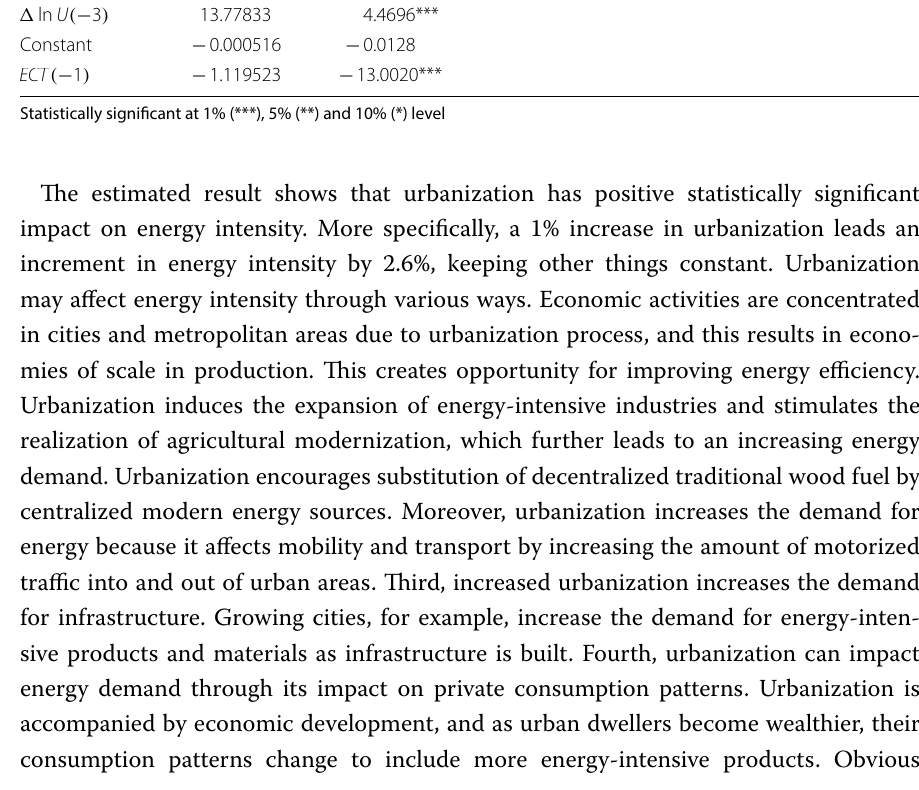
Statistically significant at 1% (***), 5% (**) and 10% (*) level